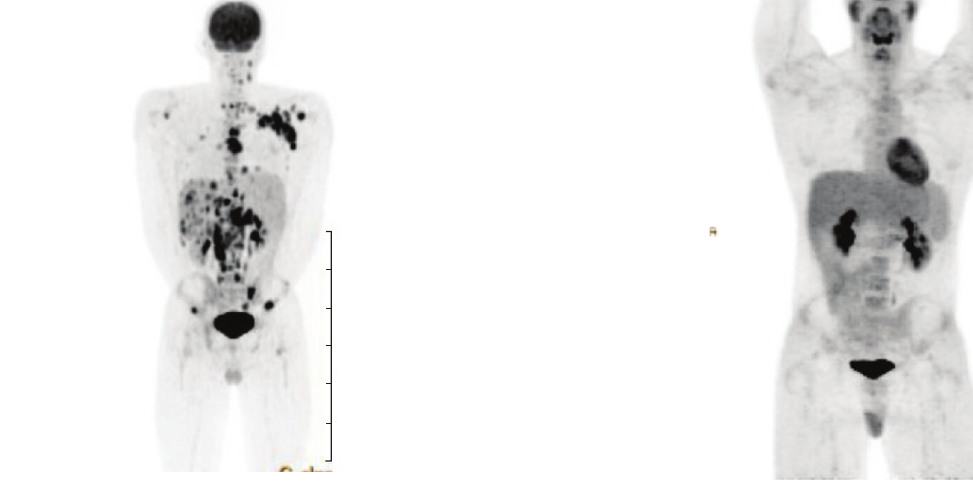
Figure 5: PET scan at Cycle 3/Day 1 showed interval resolution of FDG avid lymphadenopathy and bone lesions.